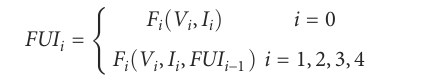
multiscale channel attention and compensation of edge information.